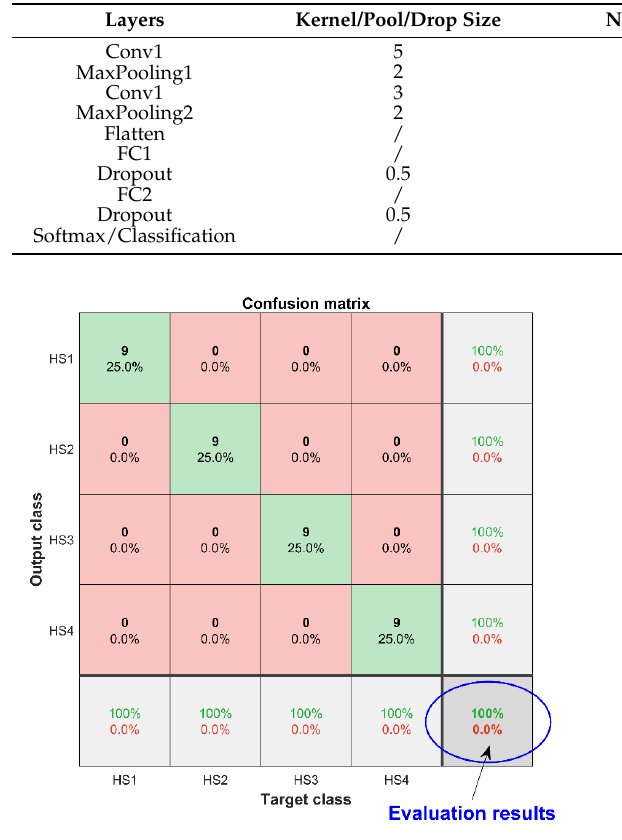
Table 7. Structural parameter settings of 1DCNN.